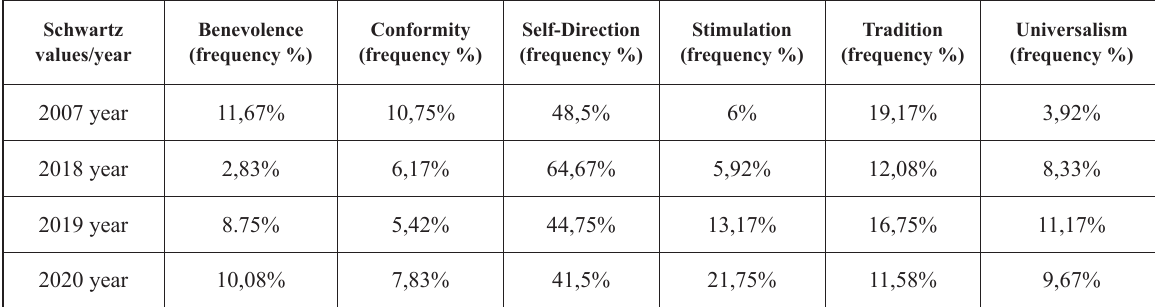
Table 2. Communication of Vilnius Book Fair programs according to Schwartz’s (2006) values Schwartz